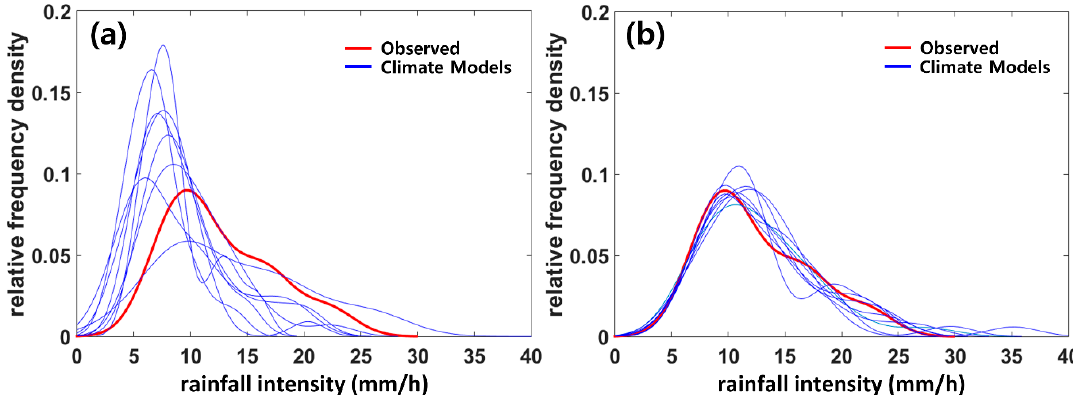
Figure 3. Frequency distribution of annual maximum rainfall intensity for duration 12 h at the Seoul site. The blue lines are empirical distributions of ( a ) un-bias-corrected and ( b ) bias-corrected annual maximum rainfall intensity time series derived from various Global Climate Model (GCM)/ Regional Climate Model (RCM)/ Representative Concentration Pathway (RCP) combinations, and the red line represents the empirical distribution of the observed annual maximum rainfall intensity time series. Table 2. Observed mean and multi-model mean for various durations at the Seoul site. Multi-Model Mean Multi-Model Mean Observed Mean Duration (h) (Before Bias-Correction) (After Bias-Correction) (mm / h) (mm/h) (mm / h)